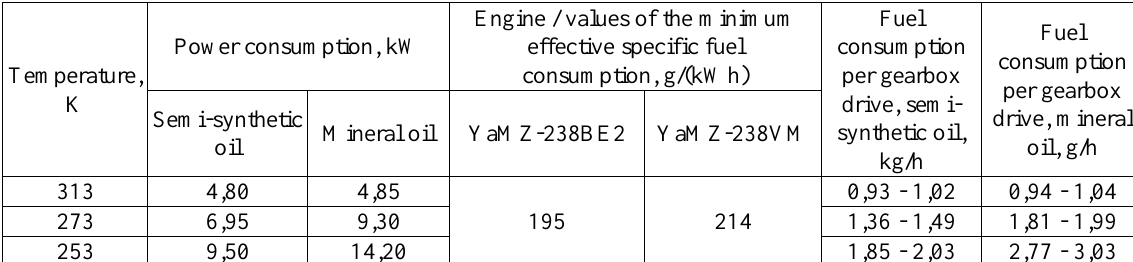
Results of calculations of fuel consumption in the gearbox of the lifting unit model UPA 60 / 80A with different power